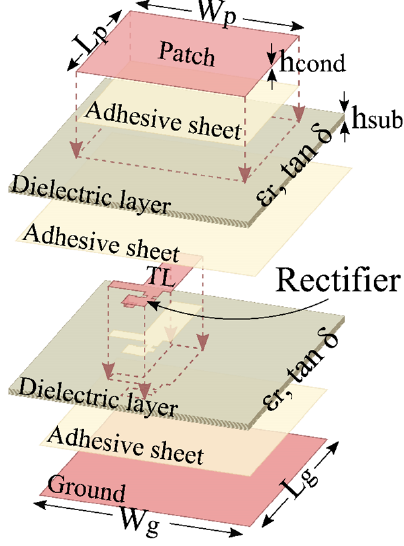
Figure 10. Perspective view of textile rectenna.